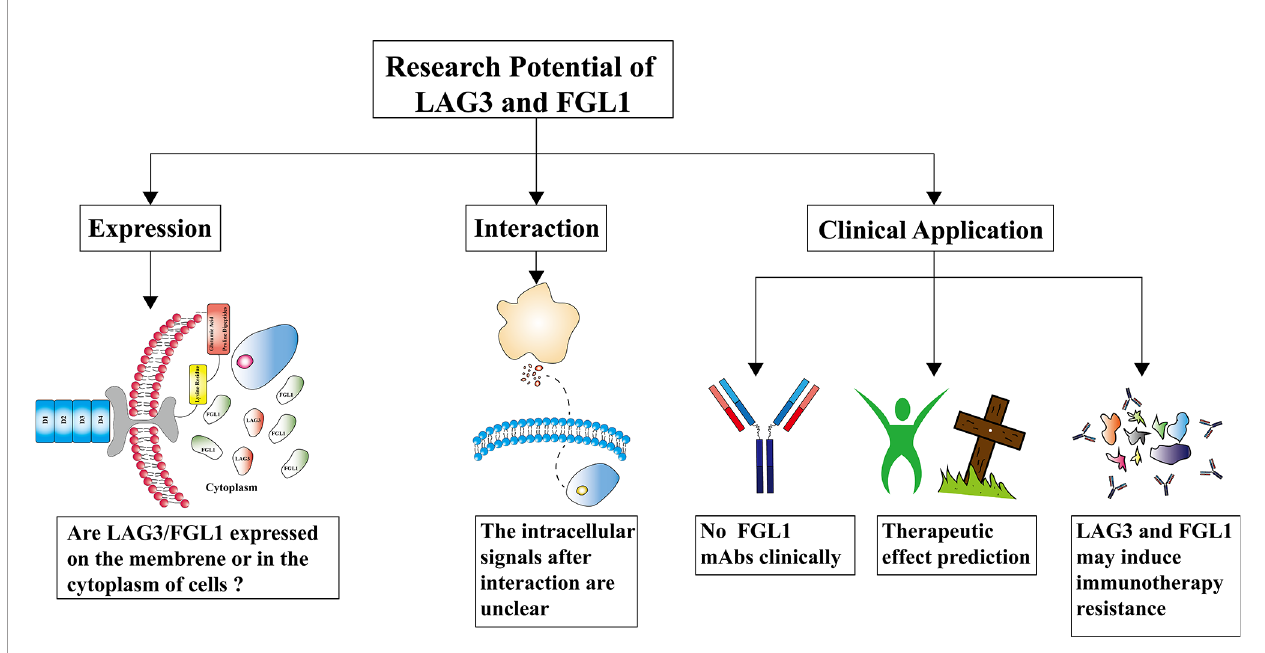
FIGURE 2 | The research potential of lymphocyte-activation gene 3/ fi brinogen like 1 (LAG3/FGL1). The expression of LAG3/FGL1 is controversial in tumors, especially that of FGL1. The mechanisms underlying the LAG3/FGL1 interaction remain unknown. How LAG3/FGL1 in the cytoplasm of NSCLC cell lines interact is unclear, and the relevant intracellular signaling changes warrant further research. Monoclonal antibodies (mAbs) targeting LAG3 are undergoing clinical trials and there are no clinical reports of FGL1 mAbs. The in fl uence of LAG3/FGL1 expression in predicting the therapeutic effect varies in different tumors and lacks the underlying rationale. LAG3 and FGL1 may induce targeted therapy resistance, but if they induce immunotherapy resistance is currently